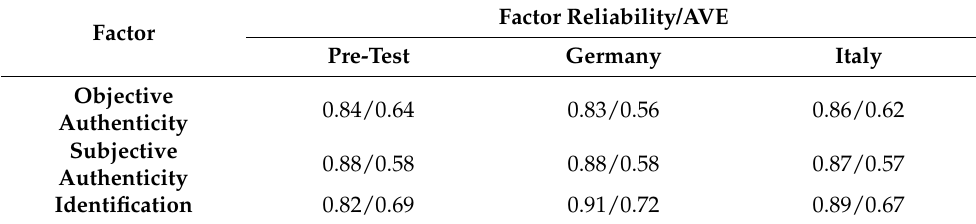
Table 3. Composite reliability.